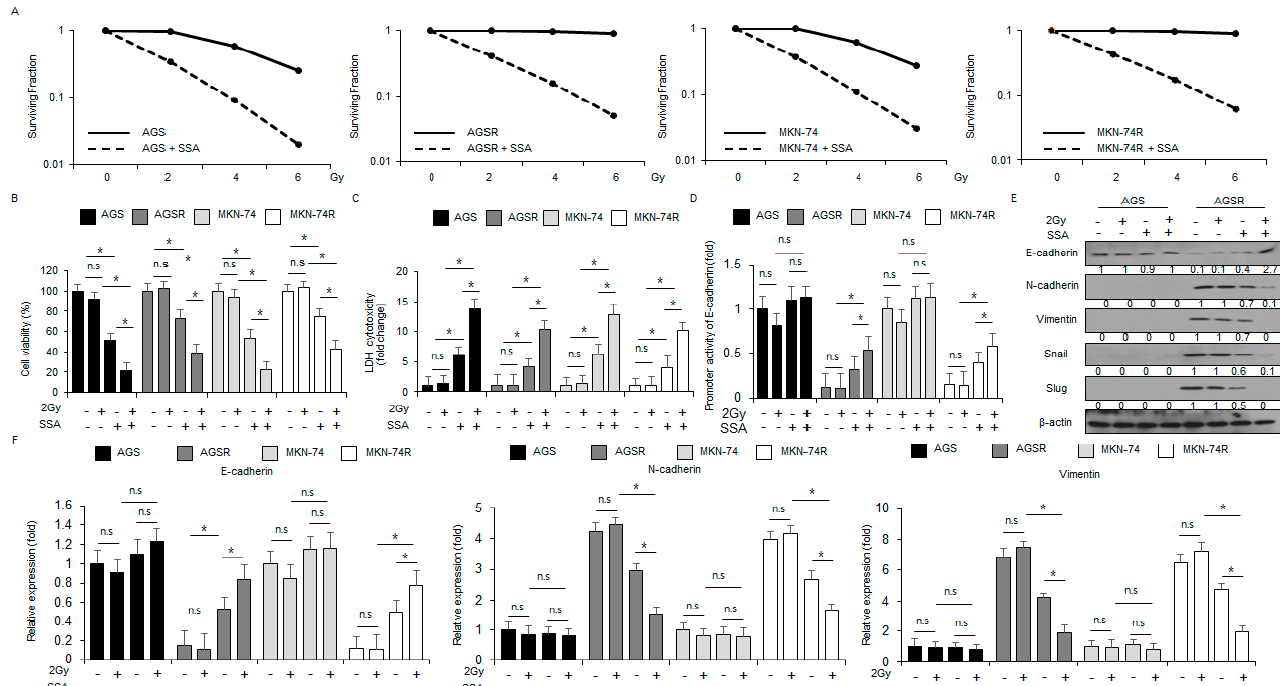
Figure 6. SSA, in combination with 2 Gy, inhibits the EMT phenotype in radio-resistant GC cells. ( A ) A colony assay was performed with SSA (10 μΜ , 24 h) treatment after exposure to the indicated radiation doses (0, 2, 4, or 6 Gy). The survival fraction was analyzed using the surviving fraction formula in AGS, MKN-74, AGSR, and MKN-74R cells; *, p < 0.05. ( B , C ) AGS, MKN-74, AGSR, and MKN-74R cells were treated with SSA (10 μΜ , 24 h) after 2 Gy radiation exposure. Cell viability and cell cytotoxicity were determined using WST-1 and LDH assays. ( D ) AGS, MKN-74, AGSR, and MKN-74R cells were transfected with a reporter luciferase vector containing an E-cadherin promoter ( − 368~+51), and were exposed to 2 Gy and SSA (10 μ M, 24 hours). The luciferase activity was normalized to the activity of Renilla luciferase; *, p < 0.05. ( E , F ) Western blot analyses for E-cadherin, N-cadherin, vimentin, Slug, and Snail were performed and then E-cadherin, N-cadherin, and vimentin mRNA levels were measured using real-time RT-PCR.